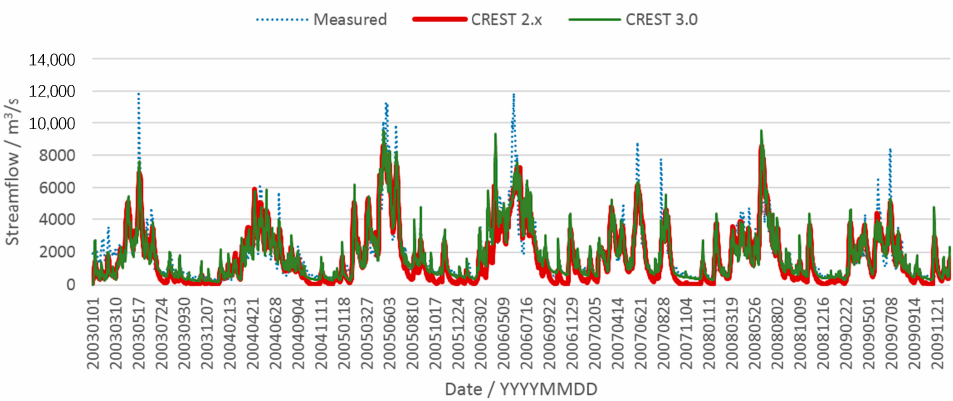
Figure 3. Hydrographs of basin outlet of CREST 2.x and 3.0 models.